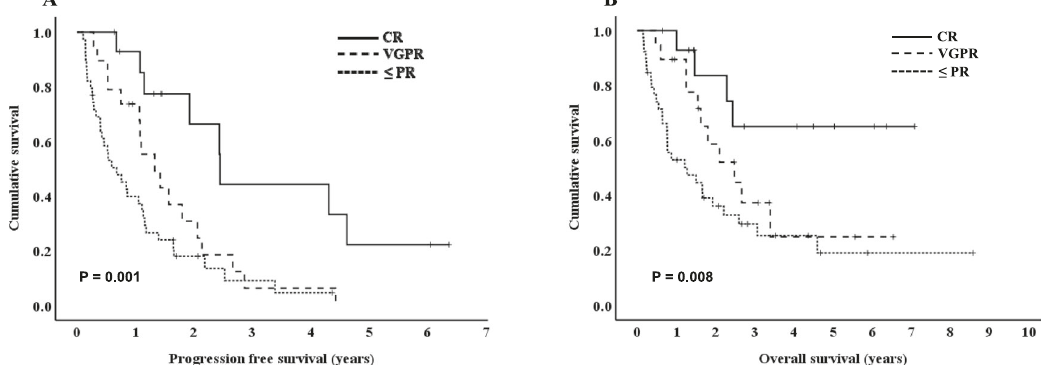
Fig. 2 Survival outcomes by the response to induction therapy in primary plasma cell leukemia. Kaplan-Meier survival curves for progression-free survival ( A ) and overall survival ( B ) based on the response to induction therapy in patients with circulating plasma cells ≥ 5%.